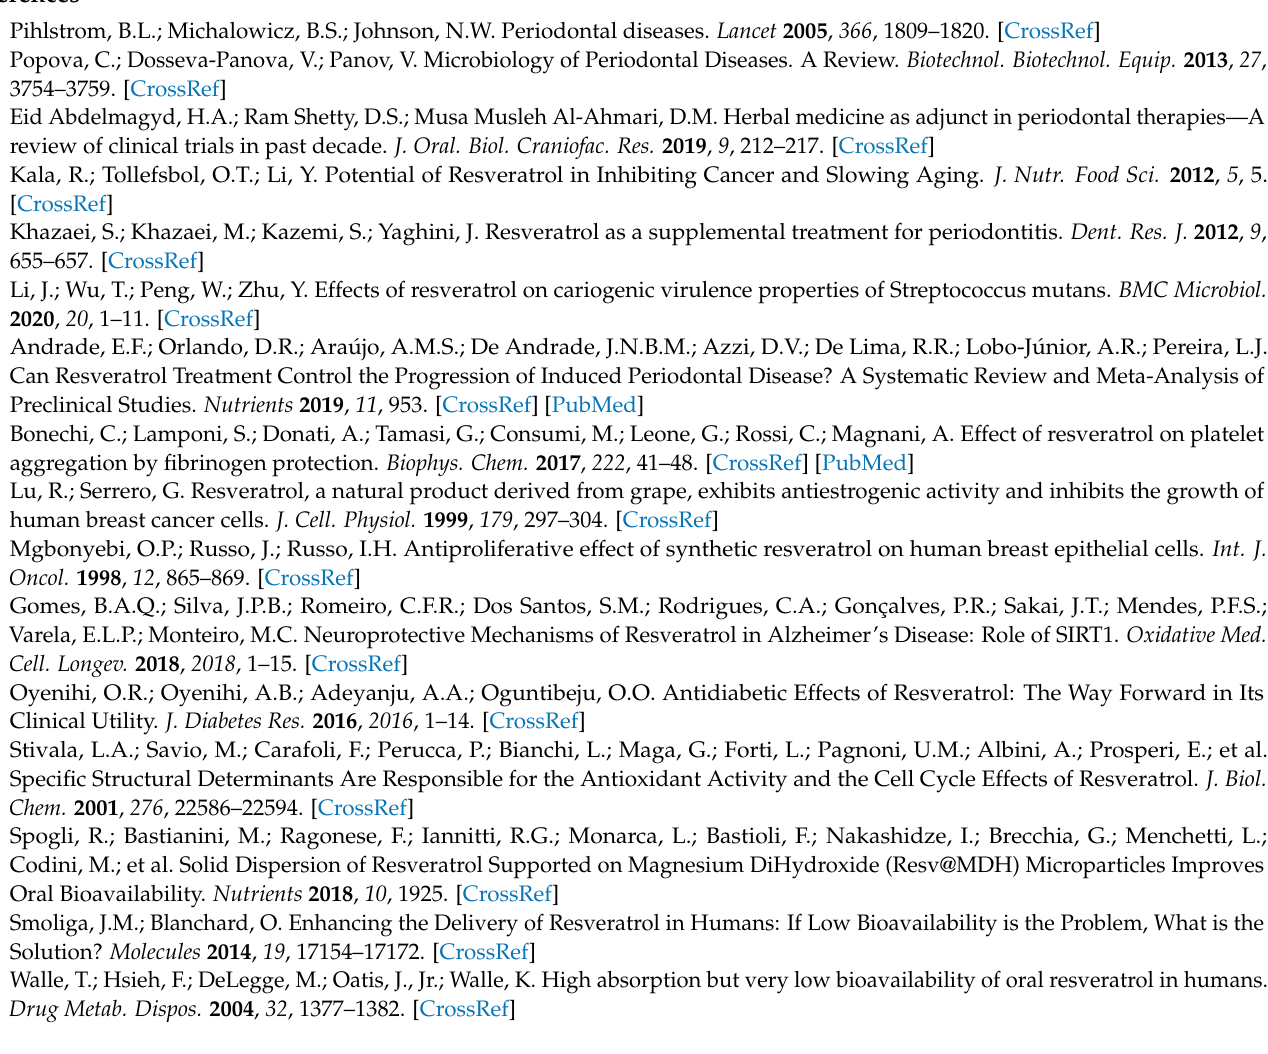
Figure S3: Dissolution profiles of the RSV/CD tablets (F1–F5), Table S3: Mathematical characteristics of the RSV/CD tablets